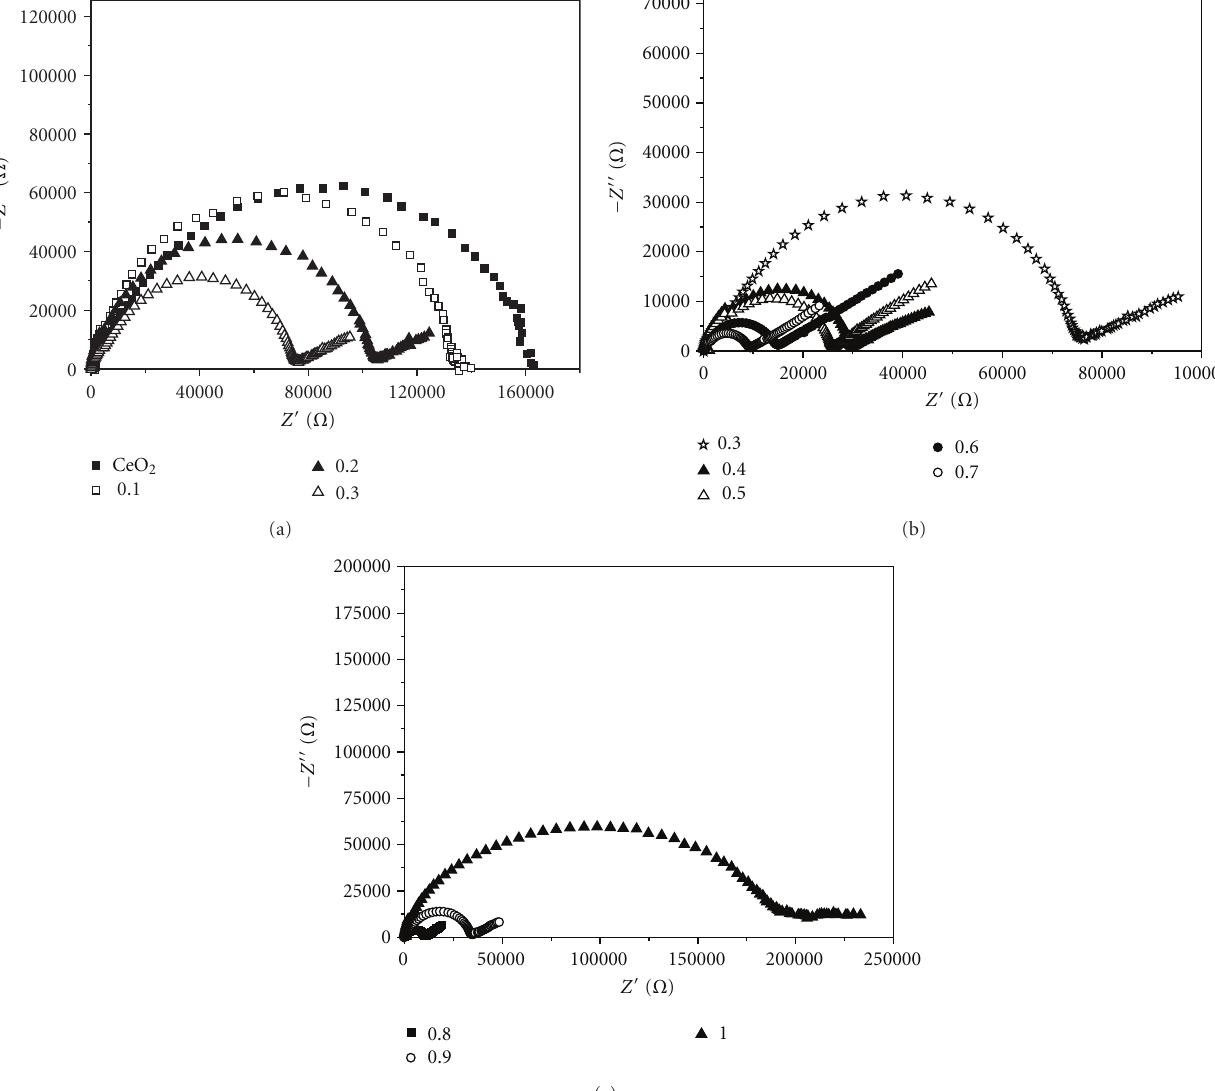
ing equivalent circuits. Figure 5(a) is relative to sample x = 0 (ceria) with equivalent circuit Z = Z 1 at 700 ◦ C. Figure 5(b) is relative to sample x = 0 . 2 with model Z = Z 1 + Z w at 400 ◦ C. Figure 5(c) is relative to sample x = 0 . 5 with equivalent circuit Z = Z 1 + Z 2 + Z w at 300 ◦ C. Figure 5(d) is relative to sample x = 0 . 8 with equivalent circuit Z = Z 3 + Z 4 + Z w at 600 ◦